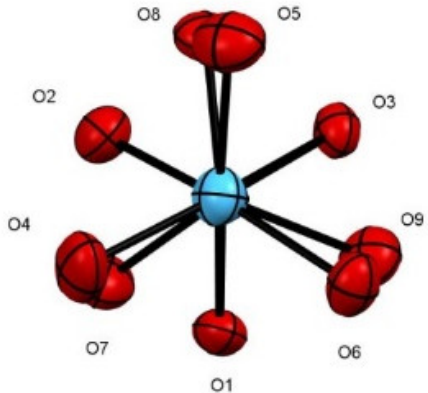
Figure 6. ORTEP drawing of 7 [Hf 2 (OBn) 8 (BnOH)]. Hydrogen atoms are omitted for clarity. Figure 7. ORTEP drawing of 7 [Hf 2 (OBn) 8 (BnOH)] from the Hf-Hf vector view showing only the oxygen atoms.